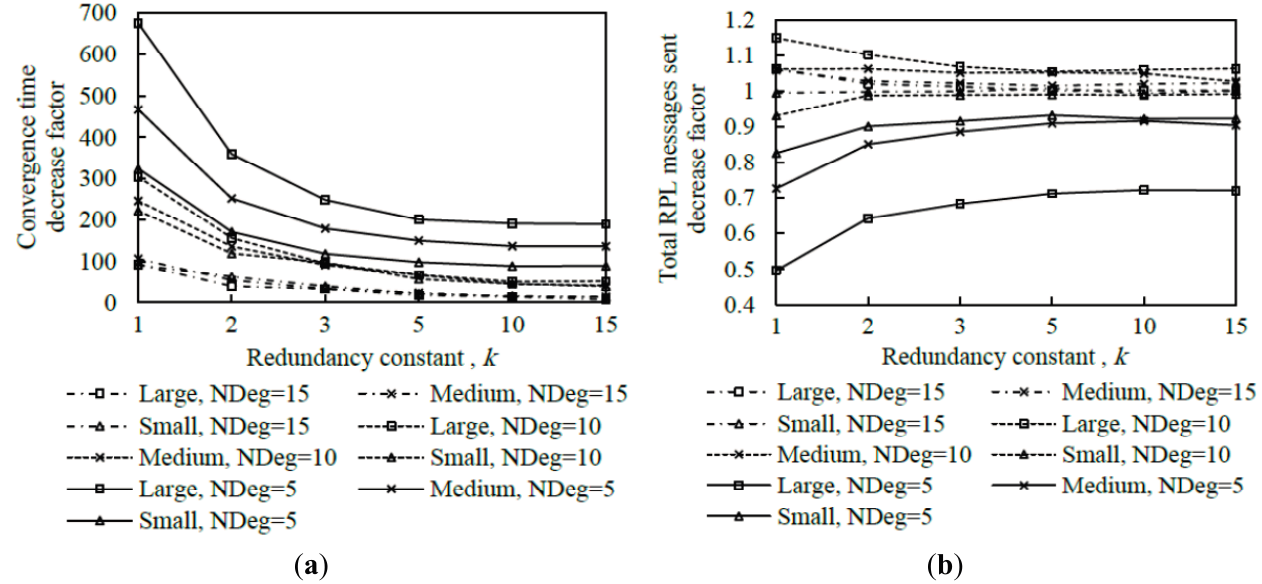
Figure 19. Convergence time ( a ) and number of DIO messages sent ( b ) improvement by using DIS-Trickle in three network size scenarios, for different average node degrees as a function of the redundancy constant, k